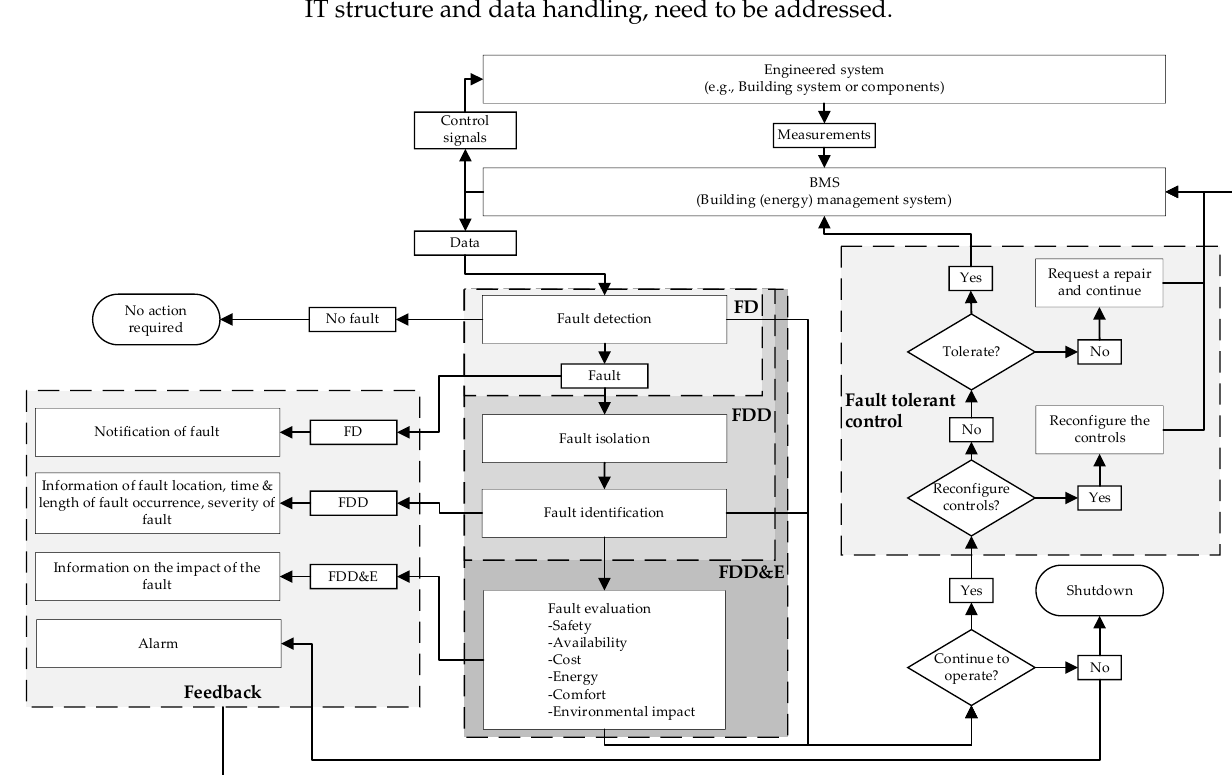
Figure 2. A generic FDD framework expanded from Katipamula et al. [10]. Permission to modify the figure was obtained from the main author of the original reference.